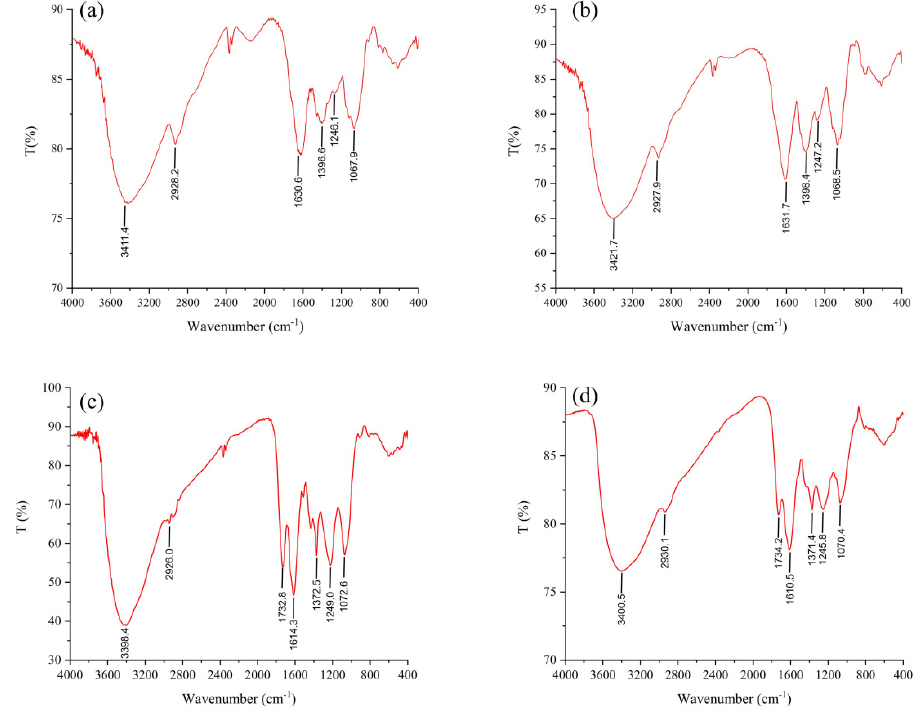
Figure 3. Fourier transform infrared spectrogram of RDP-1 ( a ), RDP-2 ( b ), AcRDP-1 ( c ), and AcRDP-2 ( d ).